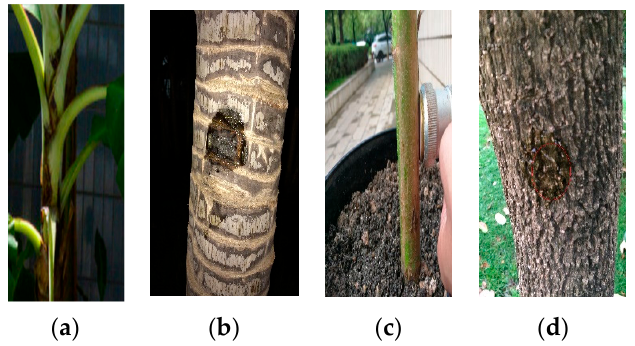
Figure 2. Testing samples. ( a ) basho; ( b ) palm; ( c ) sunflower; ( d ) magnolia denudata.